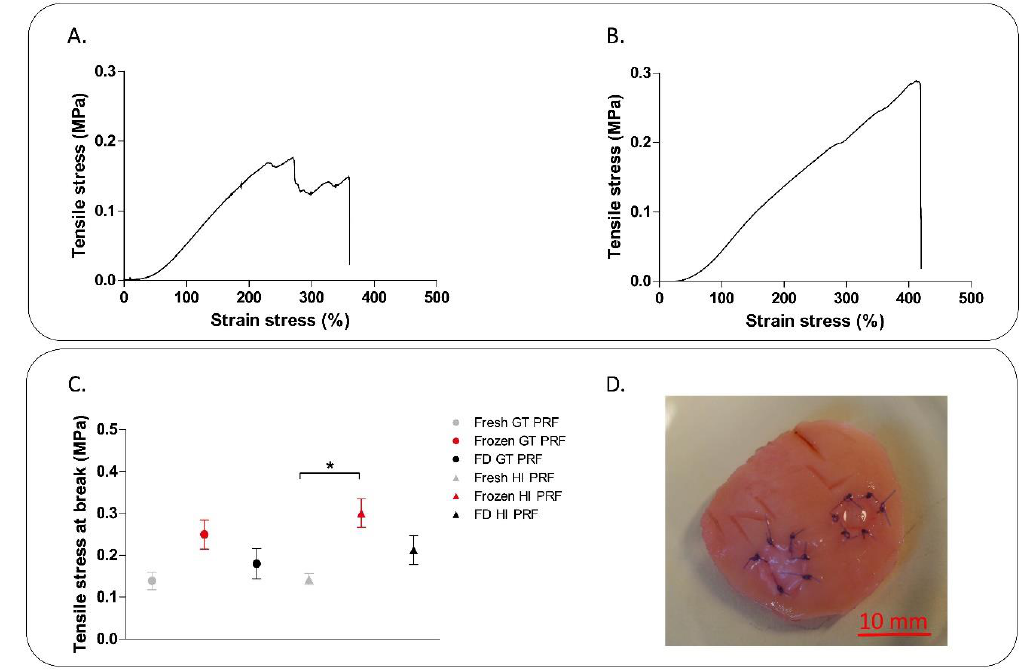
Figure 3. Tensile strength measurement of PRF membrane. ( A , B ) show the typical tensile curves of PRF membrane produced by glass blood drawing tube ( A ) and hypACT Inject ( B ) and the tensile strength of the membranes ( C ), where the maximum load at specimen failure was recorded and tensile strength was calculated. ( D ) shows the fresh HI PRF membrane sutured into hyaline cartilage